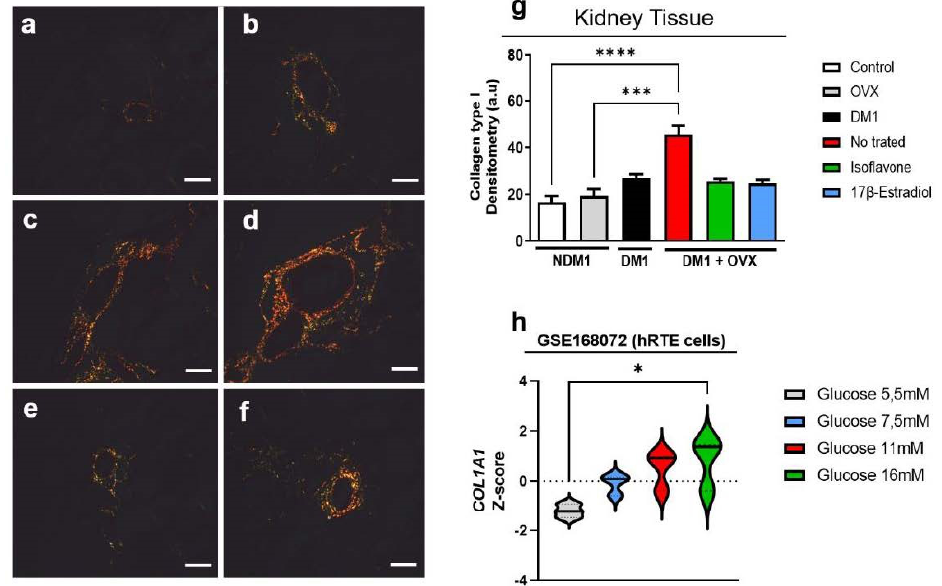
Figure 5. Isoflavone does not reduce collagen in renal tissue. Control ( a ), OVX ( b ), DM1 ( c ), untreated DM1 + OVX ( d ), DM1 + OVX treated with isoflavone ( e ), and DM1 + OVX treated with 17 β -estradiol ( f ). Densitometry analysis is represented in arbitrary units ( g ). Scale bar = 50 µ m. Transcriptome analysis ( h ). Values represent mean ± SEM ( n = 6). Kruskal–Wallis test was performed, followed by Dunn’s multiple comparison test for non-normal distribution of data (* p < 0.05; *** p < 0.001 and **** p < 0.0001).